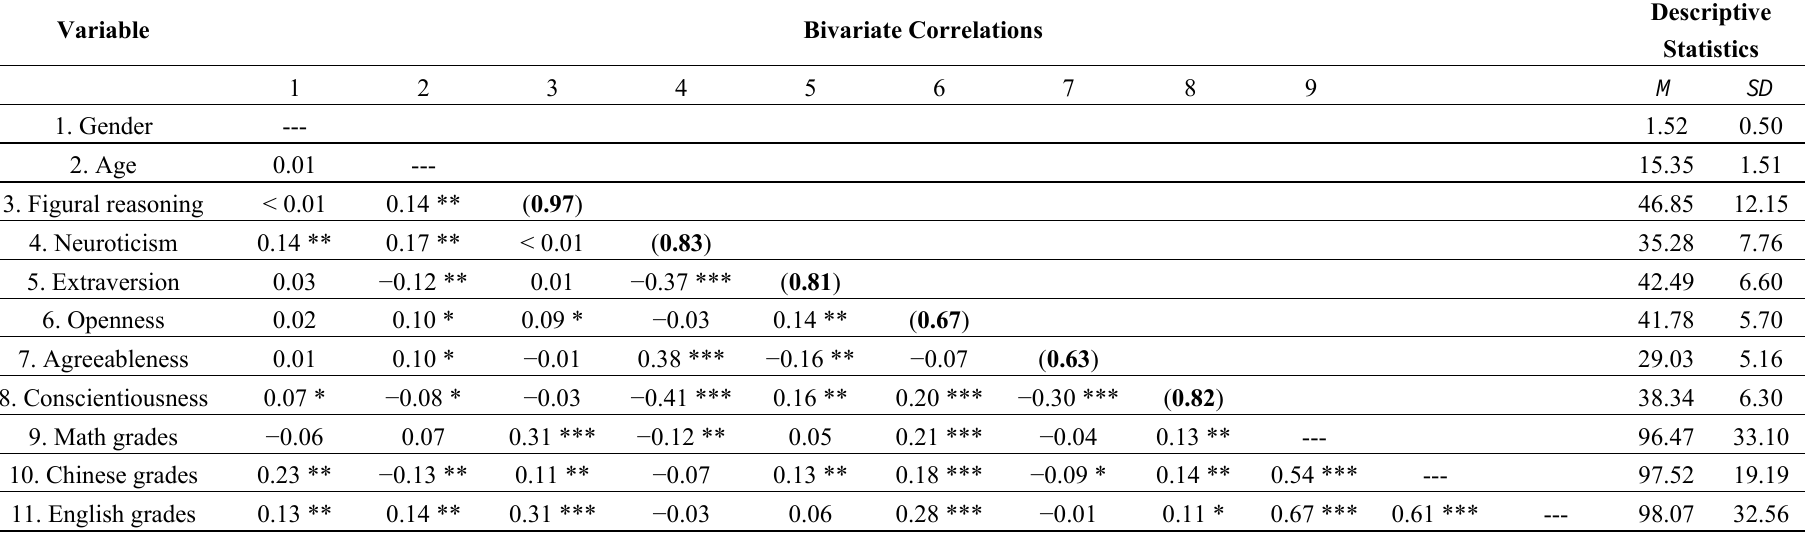
Table 1. Descriptive statistics and zero-order correlations between sum scores of all variables studied.